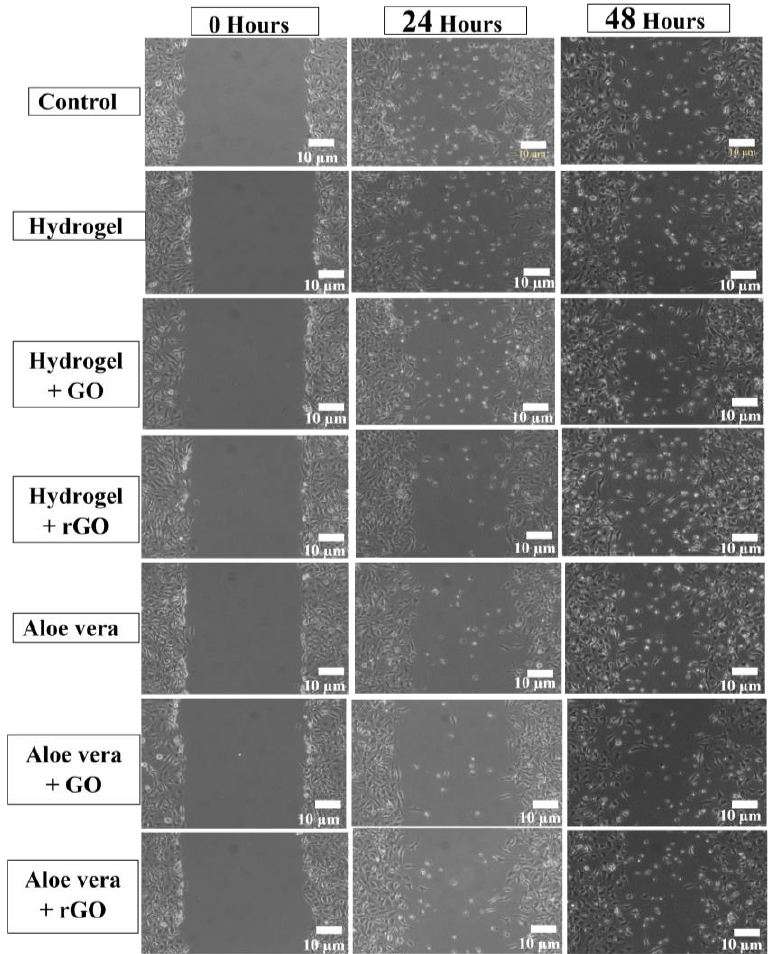
Figure 14. Wound scratch assay of GO and rGO-based composite gels on NIH 3T3 cell line. The wound scratch assay performed on the NIH 3T3 fibroblast cell reveals the wound healing capacity of the rGO-based formulations, which were better when compared to the GO-based formulations and the pure hydrogel/aloe vera gel.